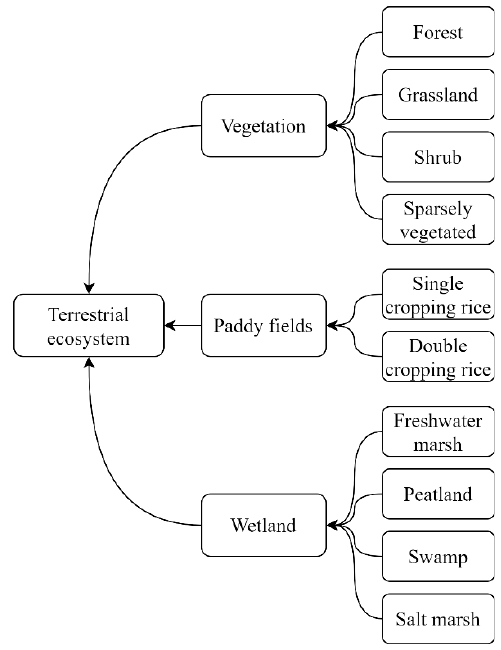
Figure 1. Main sources of CH 4 emission from terrestrial ecosystem in China.